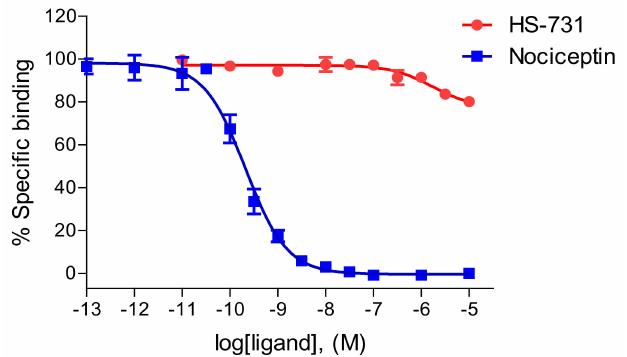
Figure 2. Binding curves of HS-731 to the human NOP receptor determined in the competitive radioli- gand binding assay. Concentration-dependent inhibition by HS-731 and nociceptin of [ 3 H]nociceptin binding to membranes from CHO cells stably expressing the human NOP receptor. Values are means ± SEM ( n = 3 independent experiments performed in duplicate).